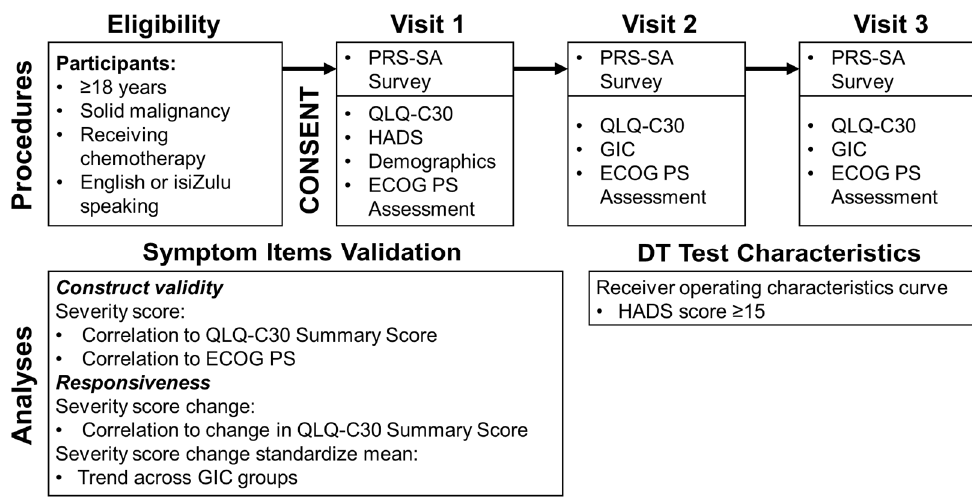
Figure 1. Procedures and analyses used for PRS-SA validation. (Abbreviations: ECOG PS-Eastern Cooperative Oncology Group performance status, GIC-Global Impression of Change questionnaire, HADS-Hospital Anxiety and Depression Scale, PRS-SA-Patient Reported Symptoms-South Africa, QLQ-C30-European Organisation for Research and Treatment of Cancer Core Quality of Life Ques- tionnaire, version 3.0).